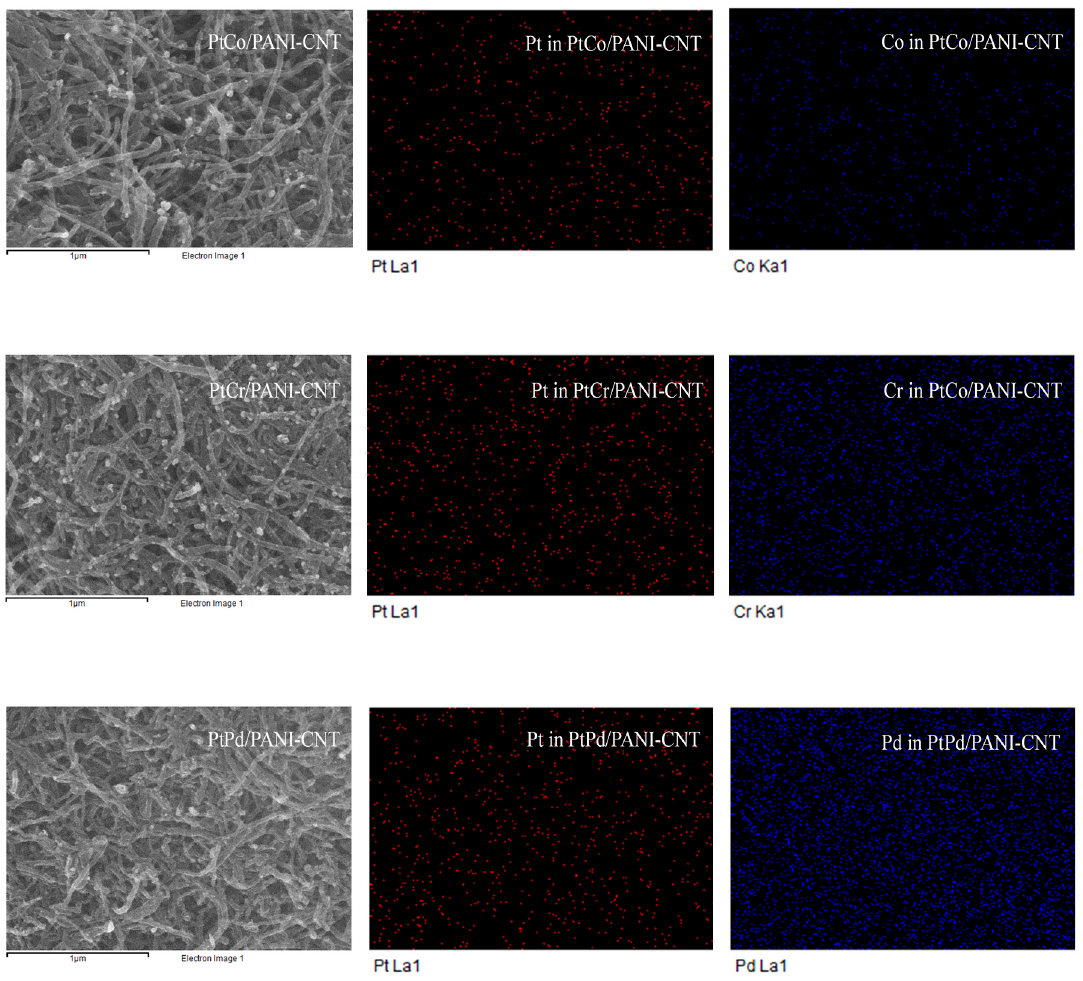
Figure 5. ( Left ) Representative SEM; and ( Middle , Right ) EDX mapping pattern of the catalysts.